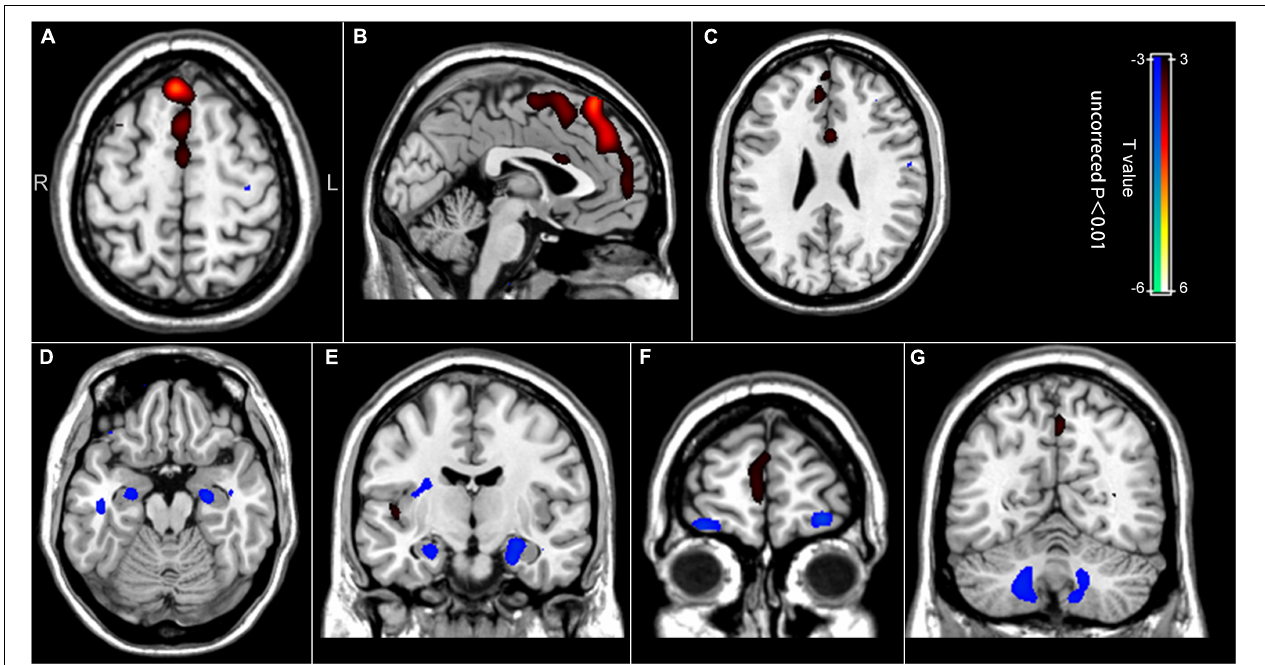
FIGURE 3 | Correlation between the regional brain glucose metabolism values and the number of chemotherapy cycles. (A–C) Positive correlation between the number of chemotherapy cycles and the regional brain glucose metabolism in the bilateral medial superior frontal gyrus, the bilateral superior frontal gyrus, the right middle frontal gyrus, the bilateral anterior cingulate cortex, and the bilateral supplementary motor area. (D–G) Negative correlation between the number of chemotherapy cycles and the regional brain glucose metabolism in the bilateral hippocampus, the bilateral orbitofrontal cortex, and the bilateral cerebellum.